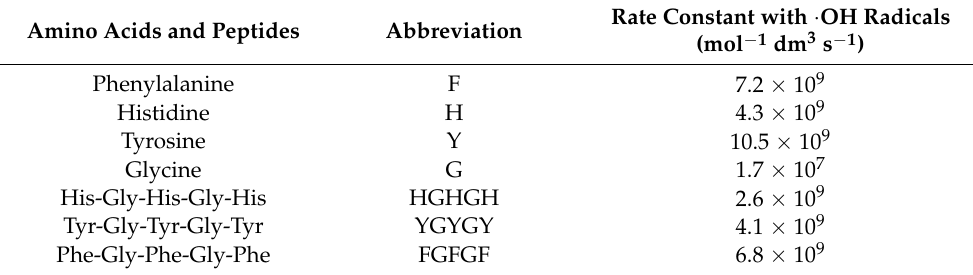
Figure 1. Decomposition of HGHGH and phenylalanine (Phe) in water by γ -ray irradiation at room temperature. temperature. Table 2. Rate constant of the synthesized peptides with ·OH radicals in water. The rate constants of the amino acids with ·OH radicals have been referred to from Masuda et al., 1973 [40]. Amino Acids and Peptides Table 2. Rate constant of the synthesized peptides with · OH radicals in water. The rate constants of the amino acids with · OH radicals have been referred to from Masuda et al., 1973